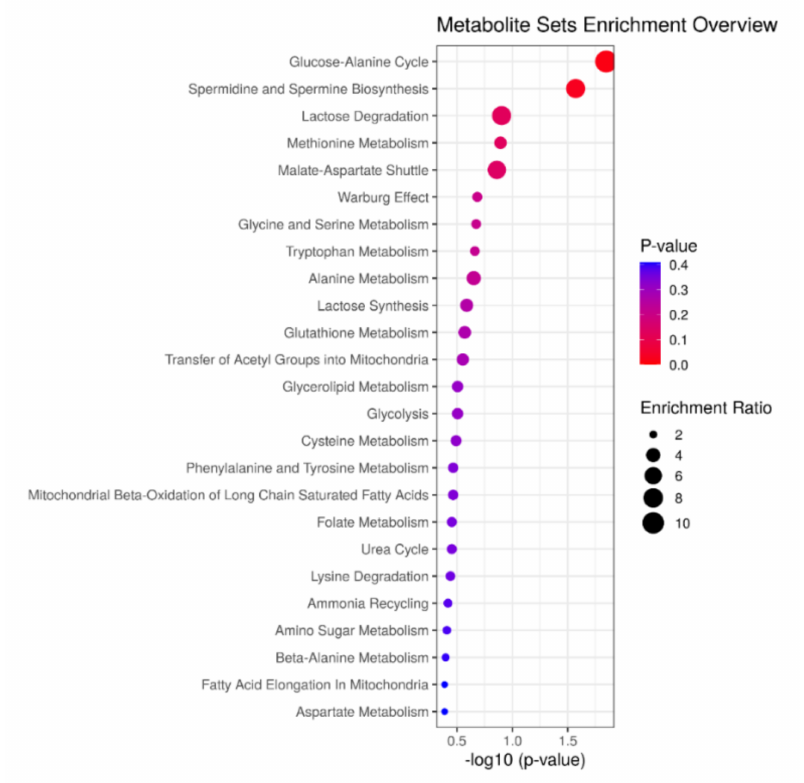
Figure 2. Pathway analysis of the deregulated metabolites in newborns to GDM mothers. The node size is proportional to the enrichment